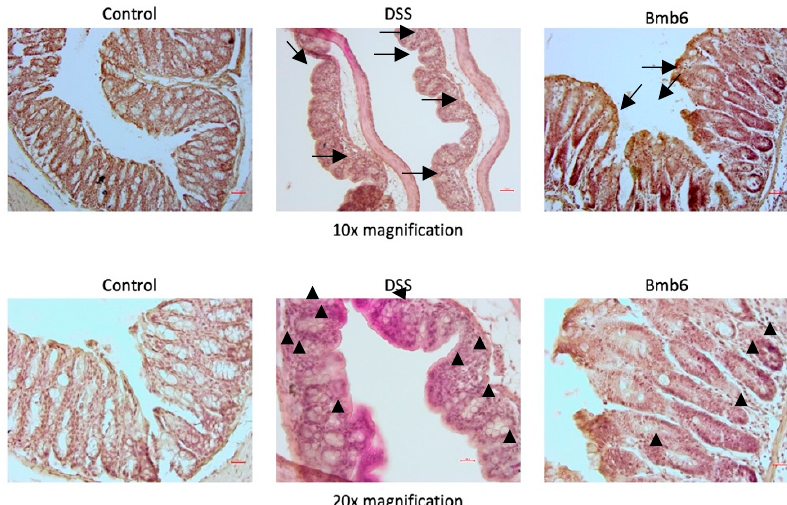
Figure 5. Hematoxylin-eosin staining of colon sections in DSS-induced colitis mice. The DSS group showed an intensive loss of intact epithelial structure (arrow) and infiltration of immune cells (arrowhead); the Bmb6 group showed slight epithelial structural damage (arrow) and infiltration of immune cells (arrowhead). Scale bar = 50 µ m for 10 × magnification; scale bar = 25 µ m for 20 × magnification.